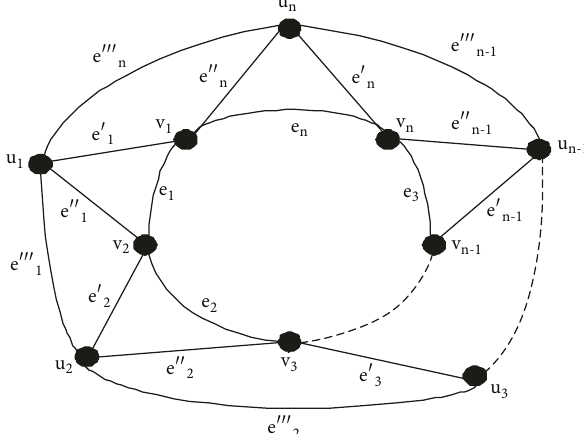
Figure 3: The total graph of cycle on n vertices, 𝑇(𝐶 𝑛 )